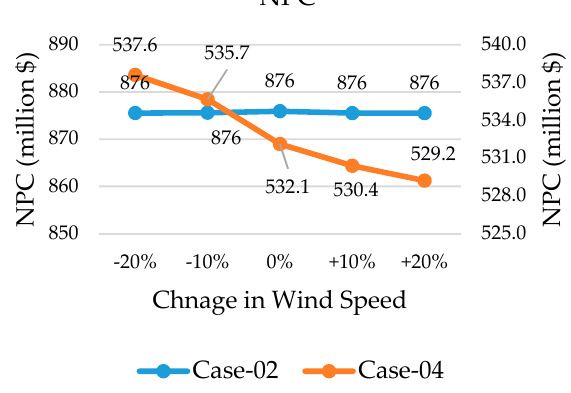
Figure 19. Sensitivity Assessment of Wind Speed on NPC.